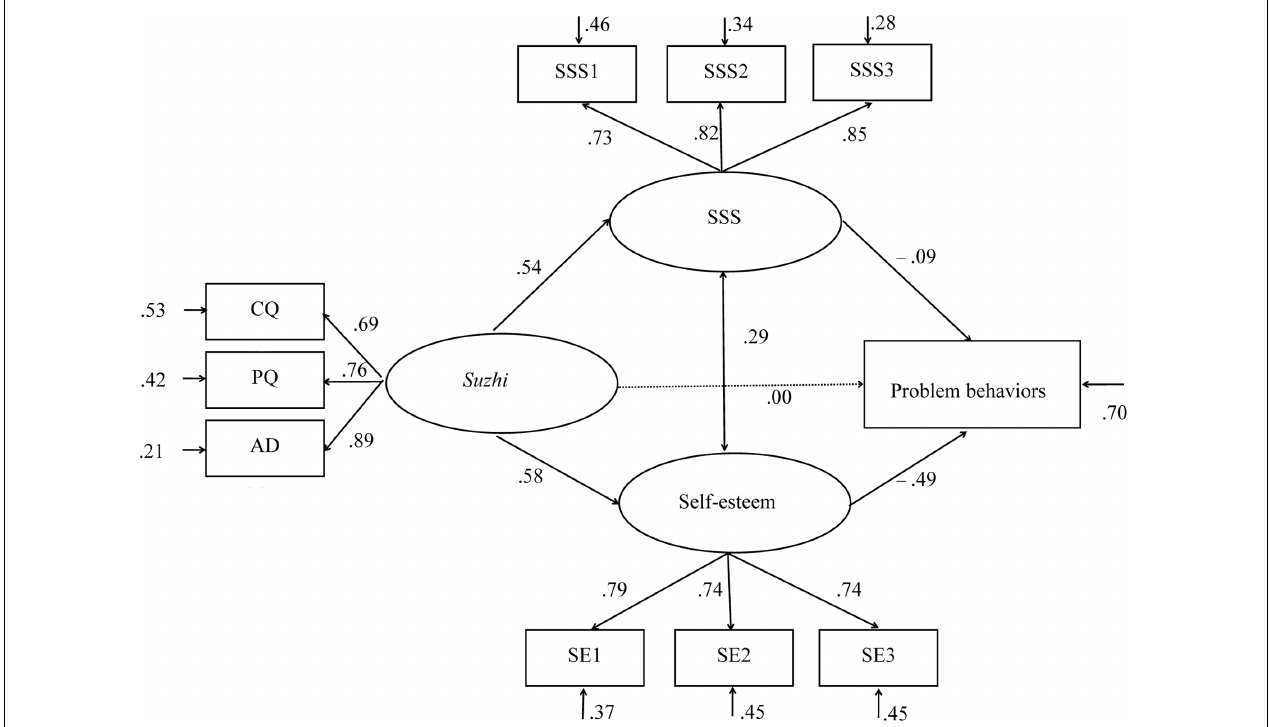
FIGURE 2 | Structural equation model with standardized parameters estimates: psychological suzhi and problem behaviors. CQ, cognitive quality; PQ, personality quality; AD, adaptability; SSS, subjective social status, SSS1–SSS3, three parcels of subjective social status; and SE1–SE3, three parcels of self-esteem.